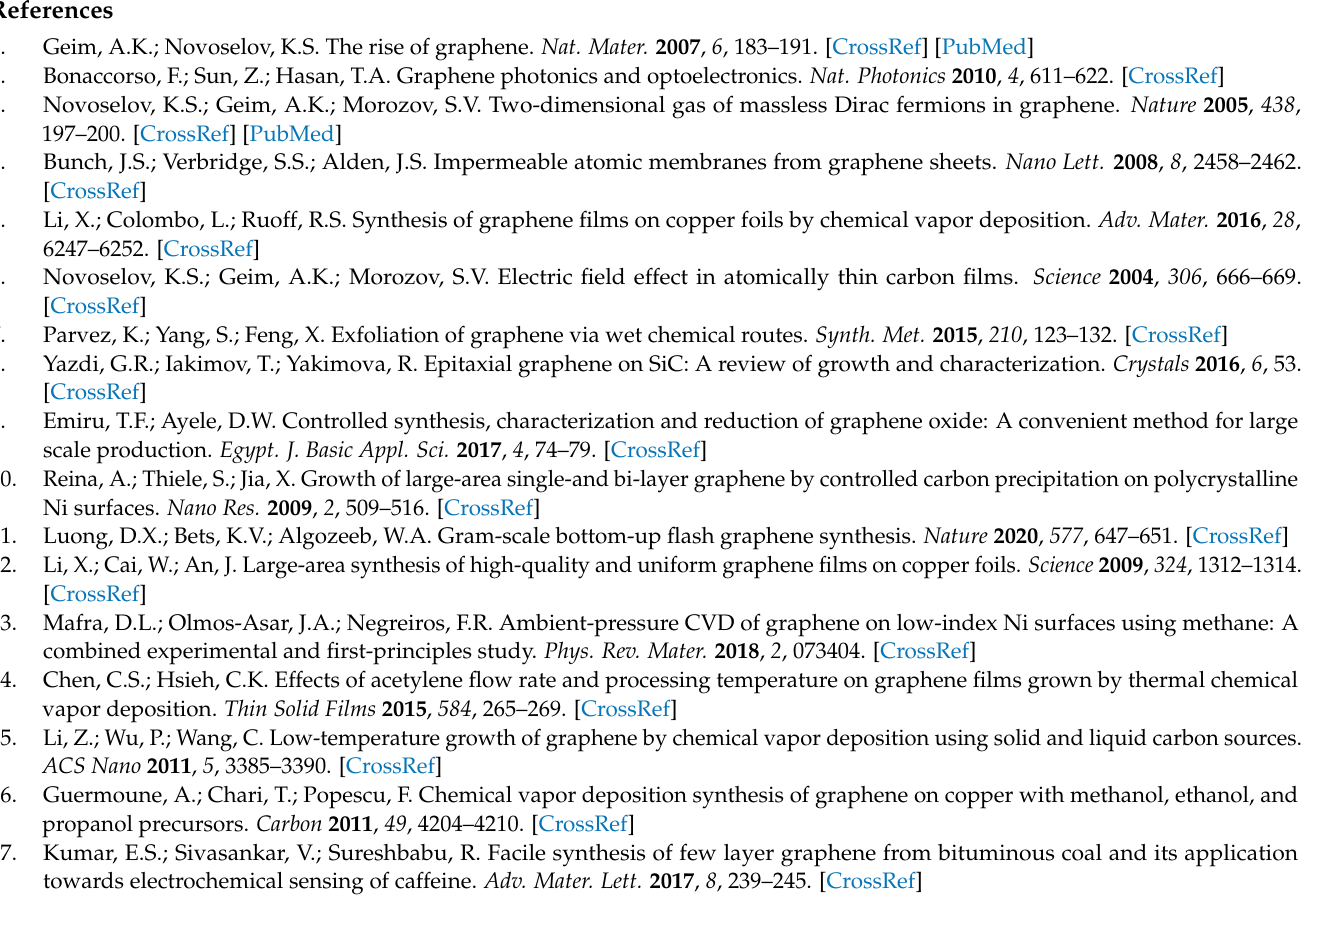
Table S1: The type of coal tar composition compounds from Chinese Shanxi Gemeng coal through pyrolysis in a 1 MW double circulating-fluidized-bed (CFB) experimental